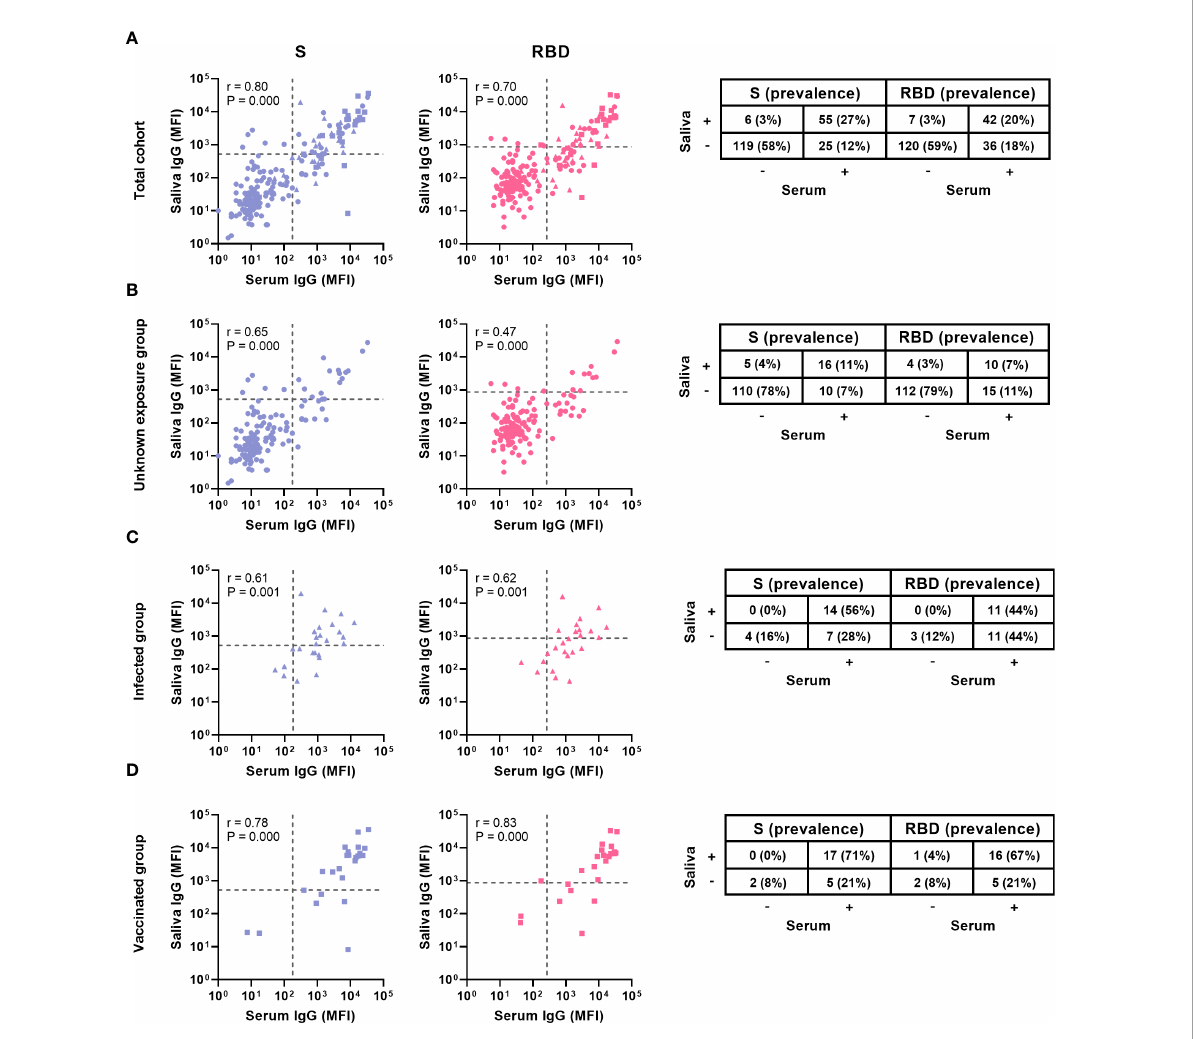
FIGURE 4 Comparison of serum and saliva antibody levels and prevalence. Levels and prevalence of S- and RBD-speci fi c antibodies of children with paired samples of (A) the total cohort (n = 194) (B) the unknown exposed group (n = 141), (C) the infected group (n = 25) and (D) the vaccinated group (n = 24) in serum and saliva (shown on the x and y axis, prevalence is indicated by the percentages). The grey dashed line represents the cut-off for each assay. Spearman ’ s rank correlations were performed and the coef fi cient (r) and the P-value are shown for each graph. S, Spike; RBD, receptor binding domain of the spike; MFI, median fl uorescence